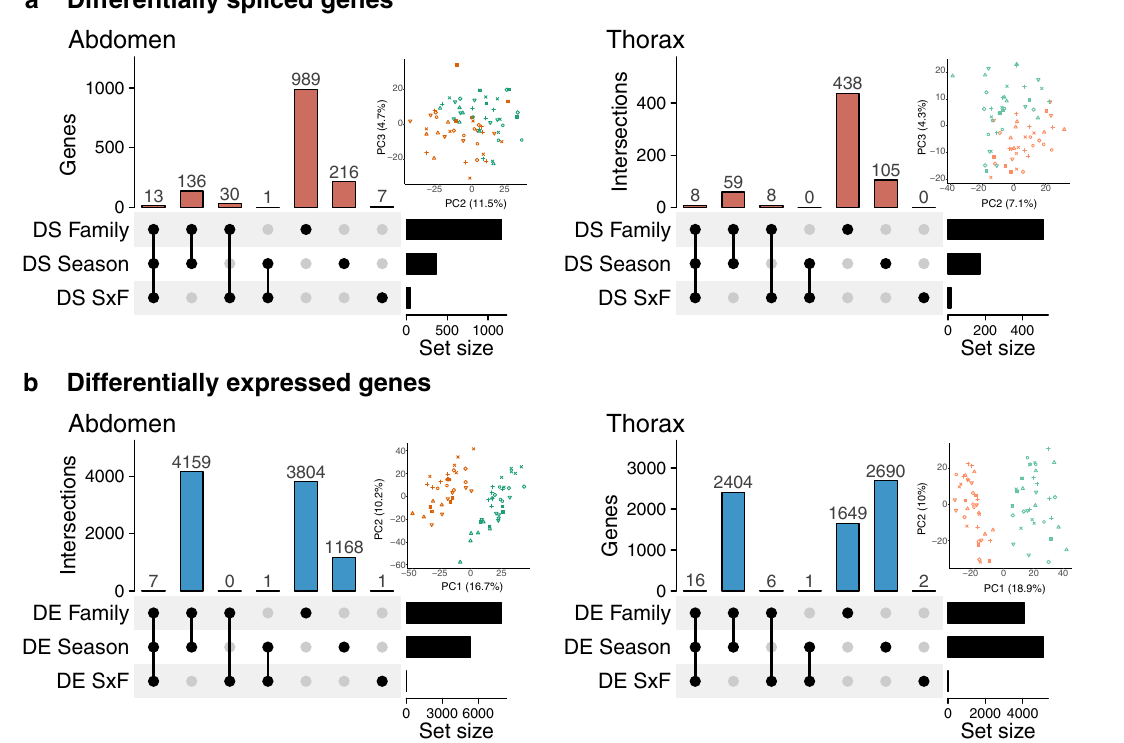
Fig. 1 Differential splicing and differential expression in two butter fl y tissues. An order of magnitude fewer genes exhibited differential exon expression a than exhibited differential whole gene expression b in both the abdomen and thorax. There were more genes (set size) with differential exon expression among families than between seasons. Only a small subset of genes showed genetic variation in seasonal plasticity of splicing (SxF). In each upset diagram, dot-plots show the overlap of analyses, vertical bars show the number of genes falling in each category, and horizontal bars show the total number of genes detected as signi fi cantly differentially spliced or differentially expressed in each analysis. There was signi fi cantly more pairwise overlap between analyses than predicted from the size of the fi ltered datasets (Supplementary Table 4). Insets show PC plots. Both relative exon expression a and gene expression b clustered by season (dry = orange, wet = green) and moderately by family (20 = circles, 21 = upward triangles, 30 = plusses, 33 = exes, 53 = diamonds, 60 = downward triangles, 69 = fi lled squares), although clustering was clearly weaker for exon expression, re fl ecting the smaller scale of differential splicing compared to differential expression in both tissues. Exon expression was analysed as normalized read counts, adjusted to re fl ect divergence from average exon expression within the genes. Source data are provided as a Source Data fi